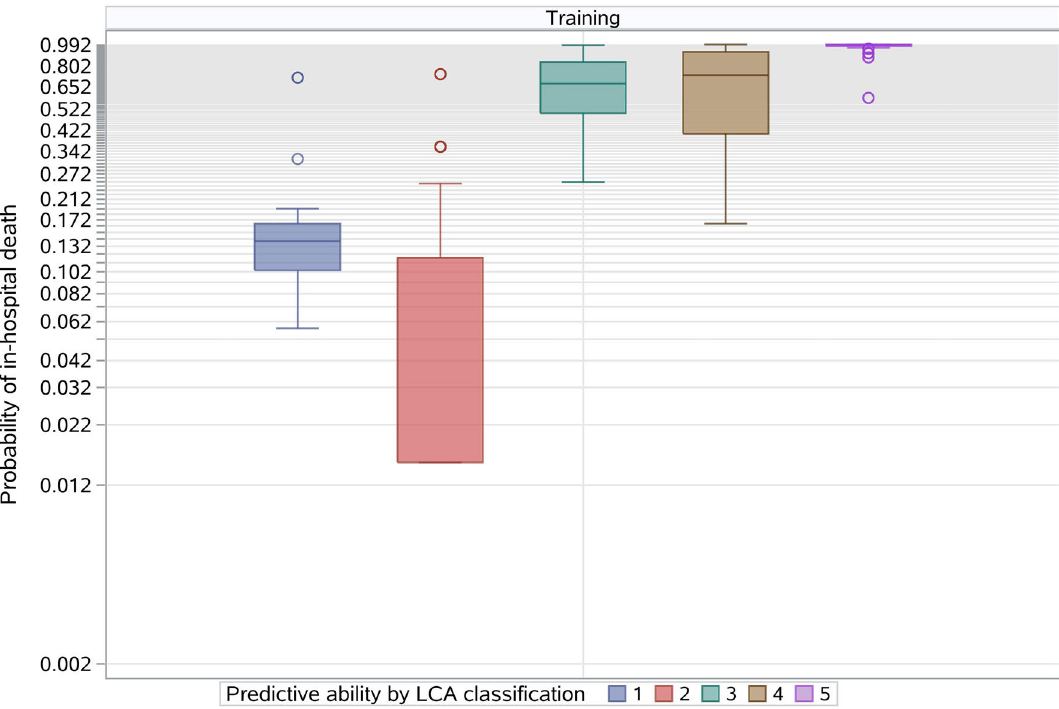
Figure 6. Risk stratification based on latent class analysis in the training sample. A total of 609 patients in the training sample were divided into five classes based on the eight risk factors. The mean observed outcome rate ranged from 0.0% in the lowest rating class to 99.2% in the highest rating class.